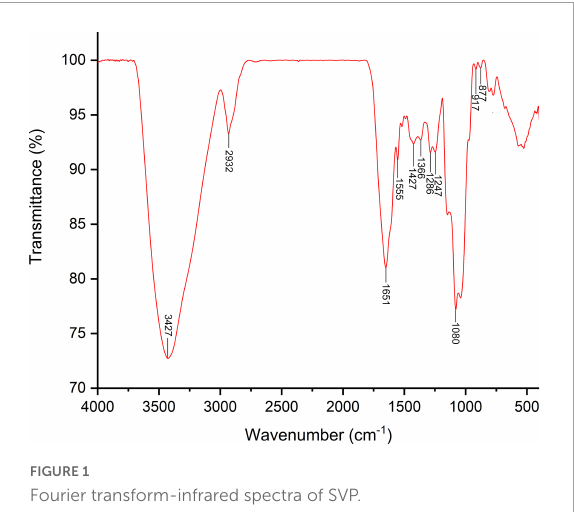
FIGURE1 Fourier transform-infrared spectra of